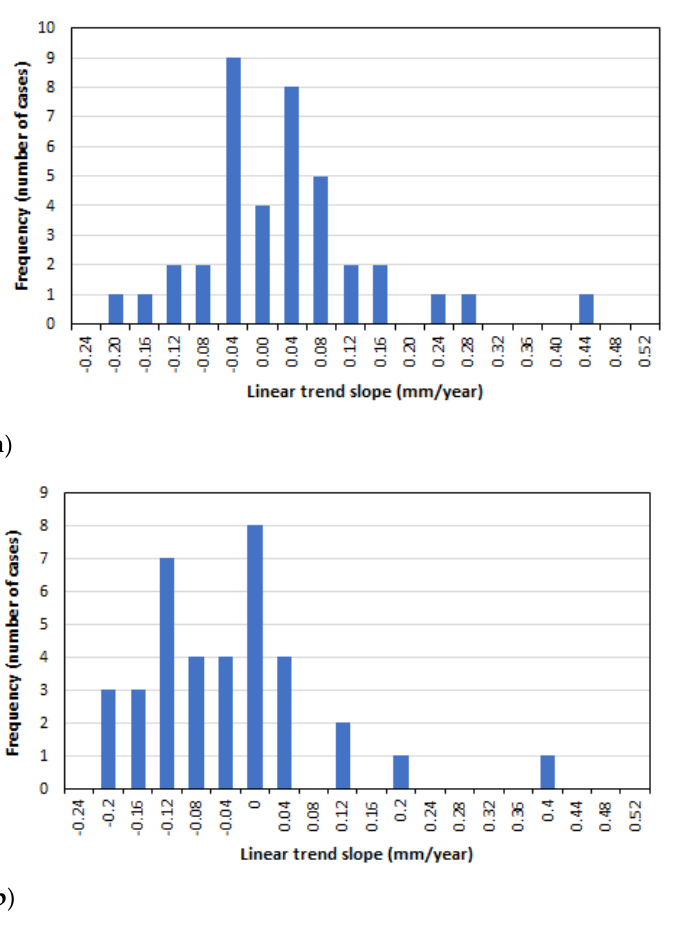
Figure 4. Frequency of the linear trend slope for ( a ) “uncorrected” and ( b ) “corrected” H d= 24 h series considering classes amplitude equal to 0.04 mm/year. All selected rain gauge stations were considered.